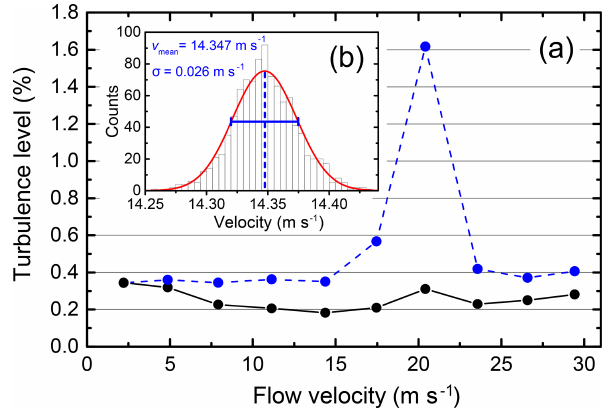
Figure 10. (a) Turbulence level of the wind tunnel (blue dashed line – initially, without air inlet; black line – with air inlet). (b) Typ- ical histogram of acquired LDA data at constant flow speed with Gaussian fit (red